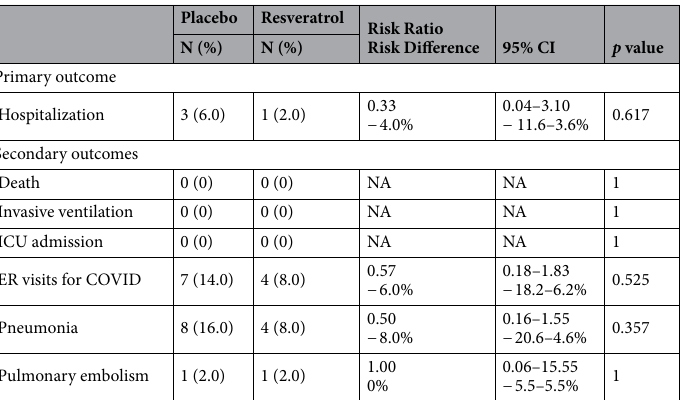
Table 3. Primary and secondary outcomes, as observed, by study group. All outcomes evaluated over the 21 days that followed patient randomization to study group. Outcomes observed for N = 50 patients per group. NA = not applicable; CI = confidence interval; ICU = intensive care unit; ER = emergency room. p -value from Fisher’s exact test. p -values not adjusted for multiple comparisons.